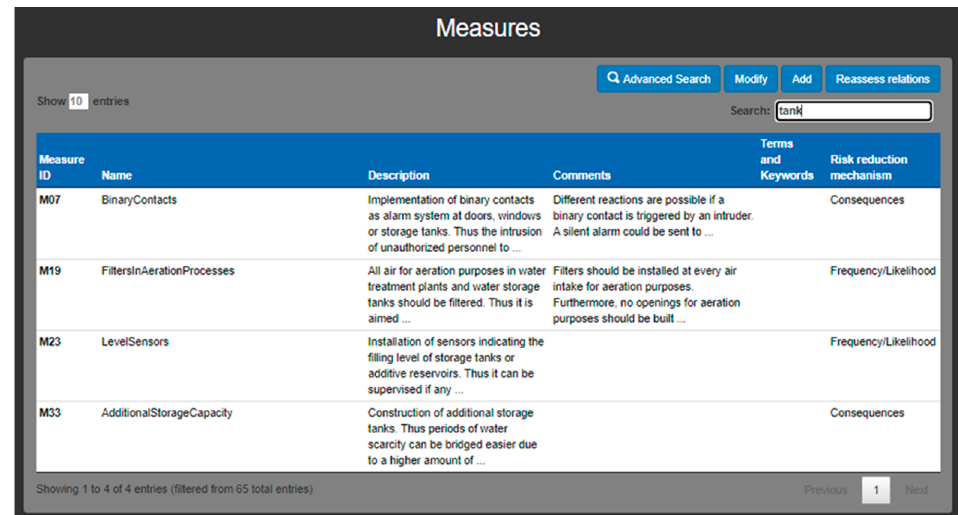
Figure 10. User interface of the RRMD displaying suggested risk reduction measures.